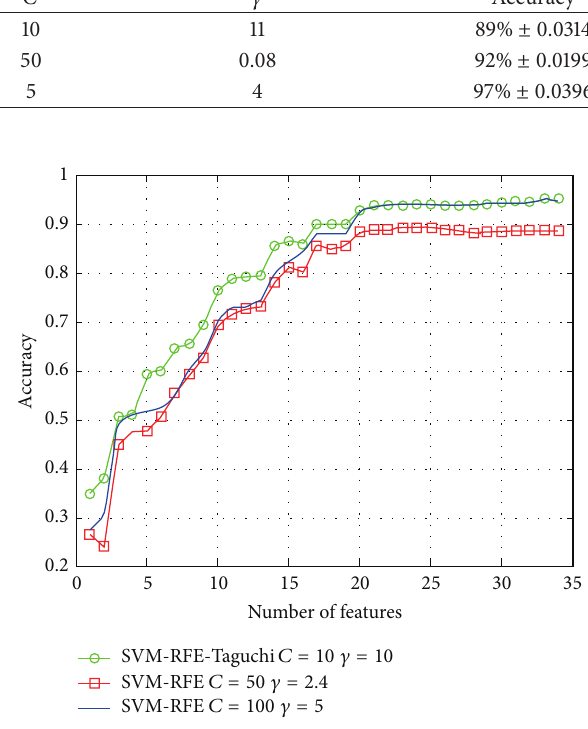
Figure 4: Classification performance comparison of Dermatology